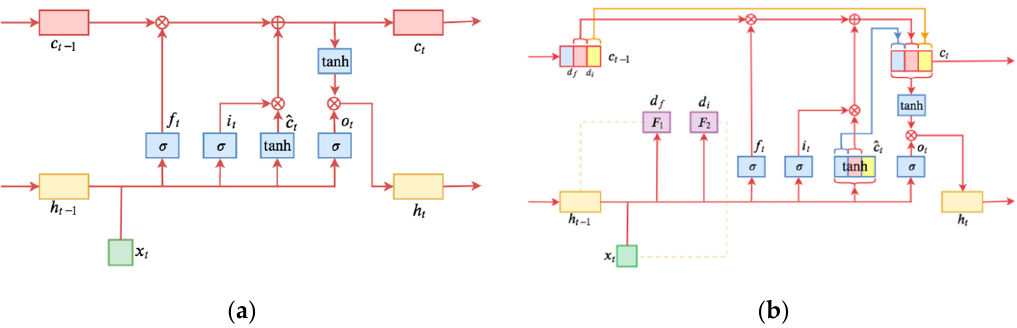
Figure 2. Comparison of LSTM and MS-LSTM: ( a ) Standard LSTM; ( b ) MS-LSTM .